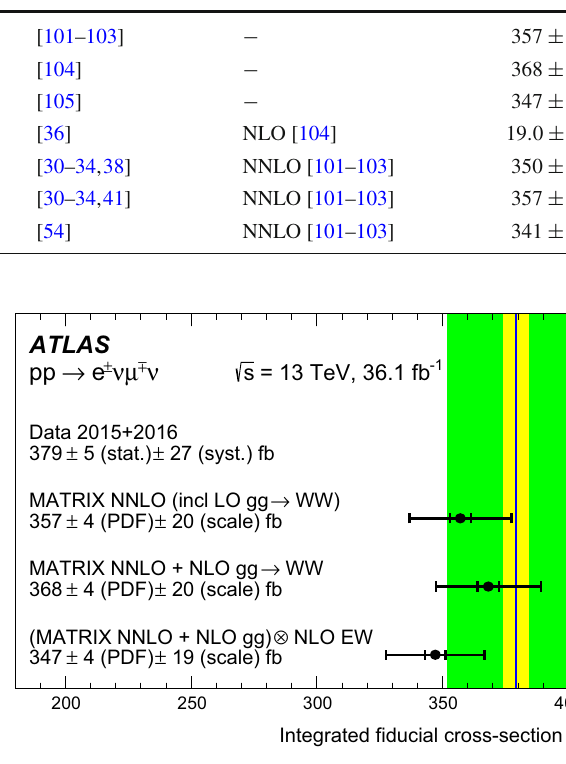
corrections, discussed in detail in Sect. 8. The